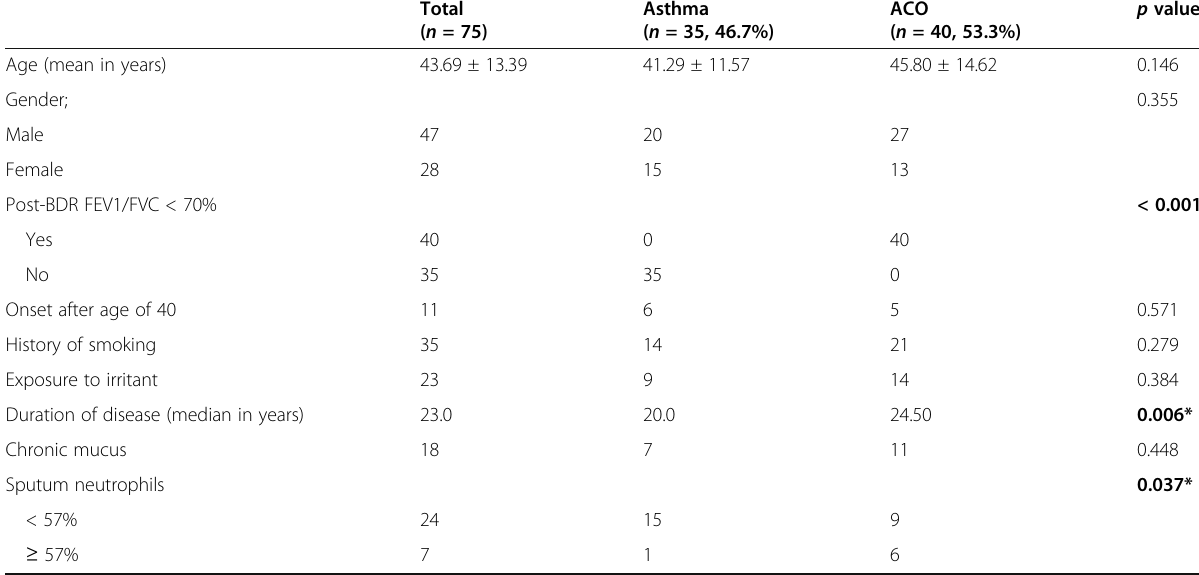
Table 1 Patients characteristics in group